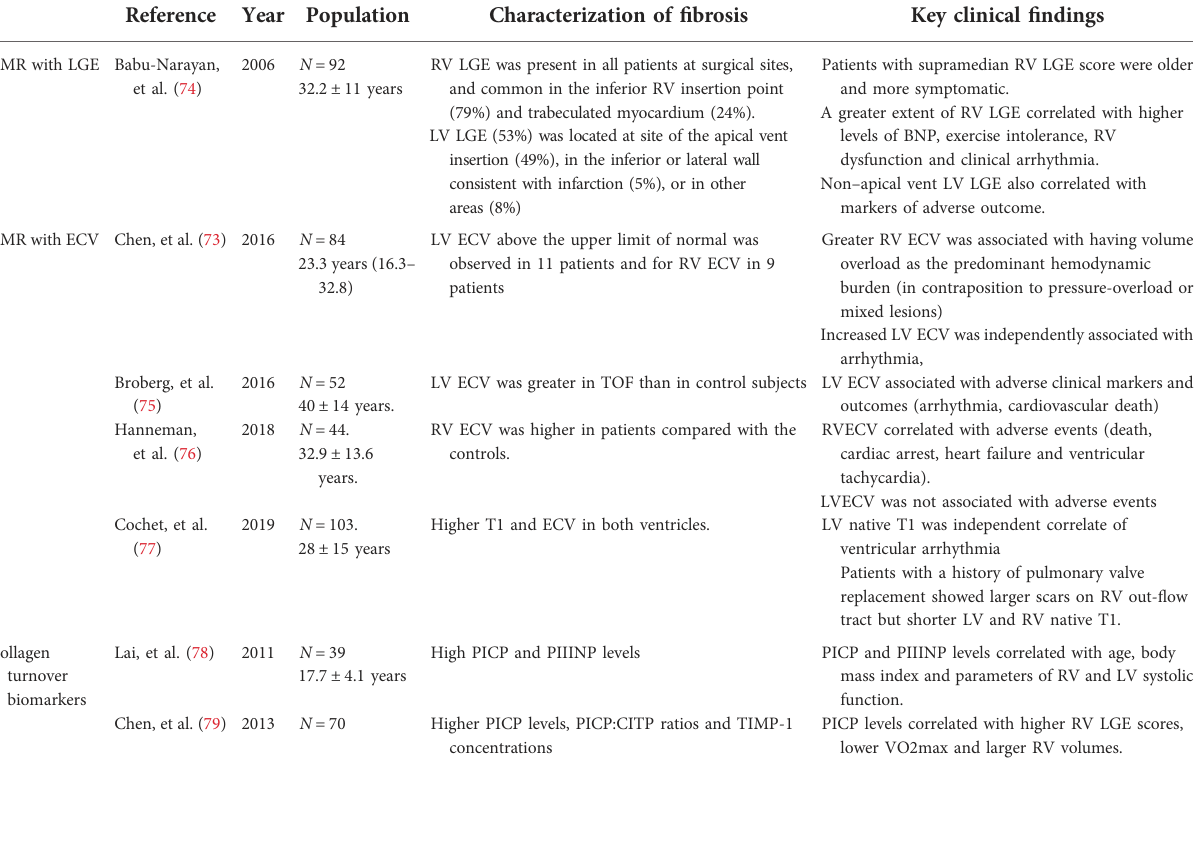
TABLE 1 Most relevant studies characterizing myocardial interstitial fi brosis with cardiac magnetic resonance and collagen turnover biomarkers in patients with repaired tetralogy of Fallot.